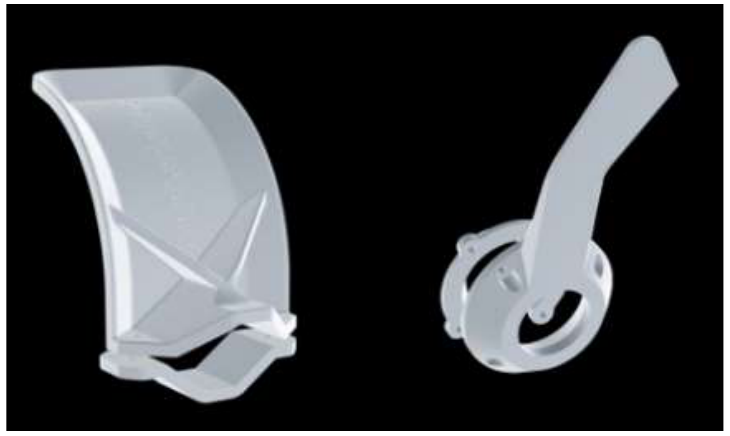
Figure 10. The 3D printable hands-free door opener from Materialise [76].